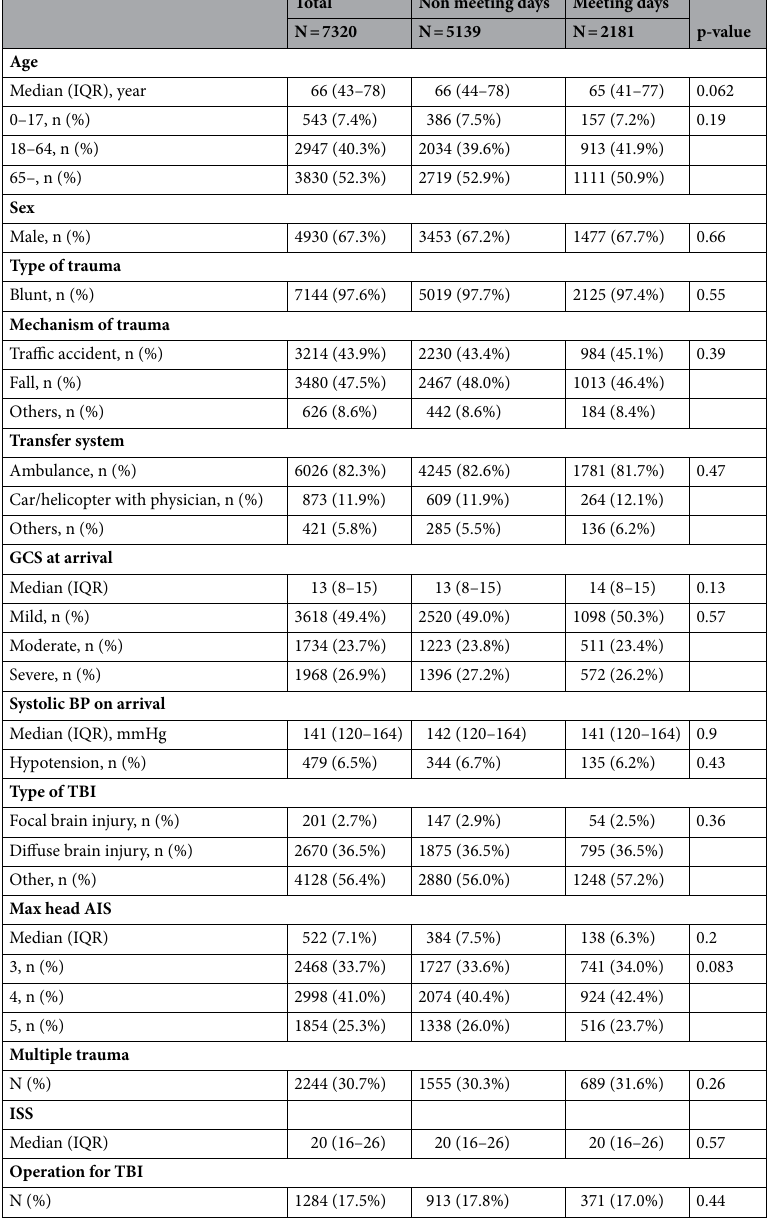
Table 1. Information on patient background between meeting days and non-meeting days. TBI traumatic brain injury, GCS glasgow coma scale, BP blood pressure, AIS abbreviated injury scale, ISS injury severity score, IQR interquartile